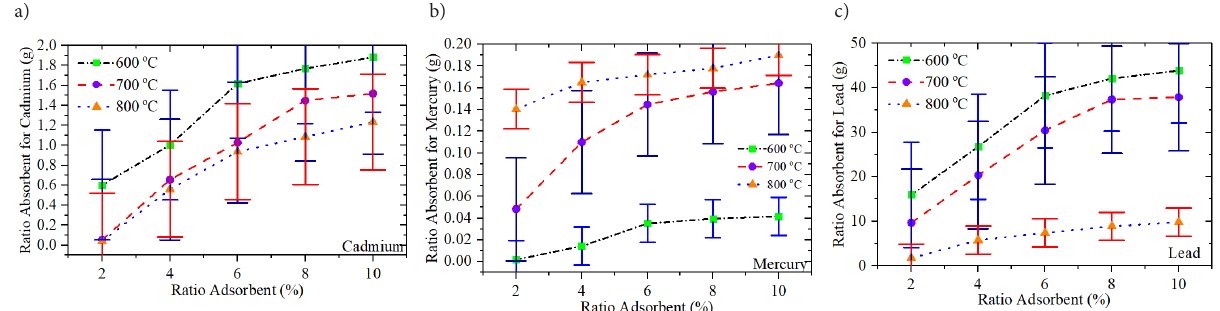
Figure 5. Total metal Cd, Pb, and Hg absorbed based on adsorbent ratio at different